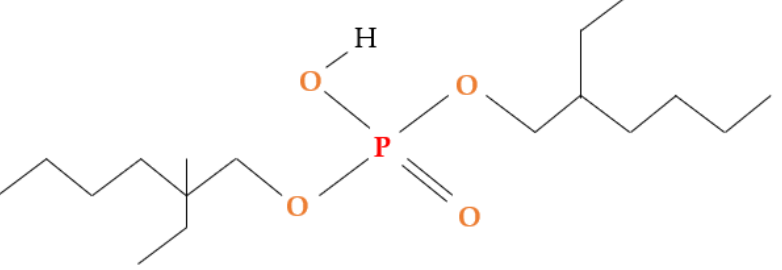
Figure 1. Chemical structure of bis-(2-ethylhexyl) phosphate (B 2 EHP).